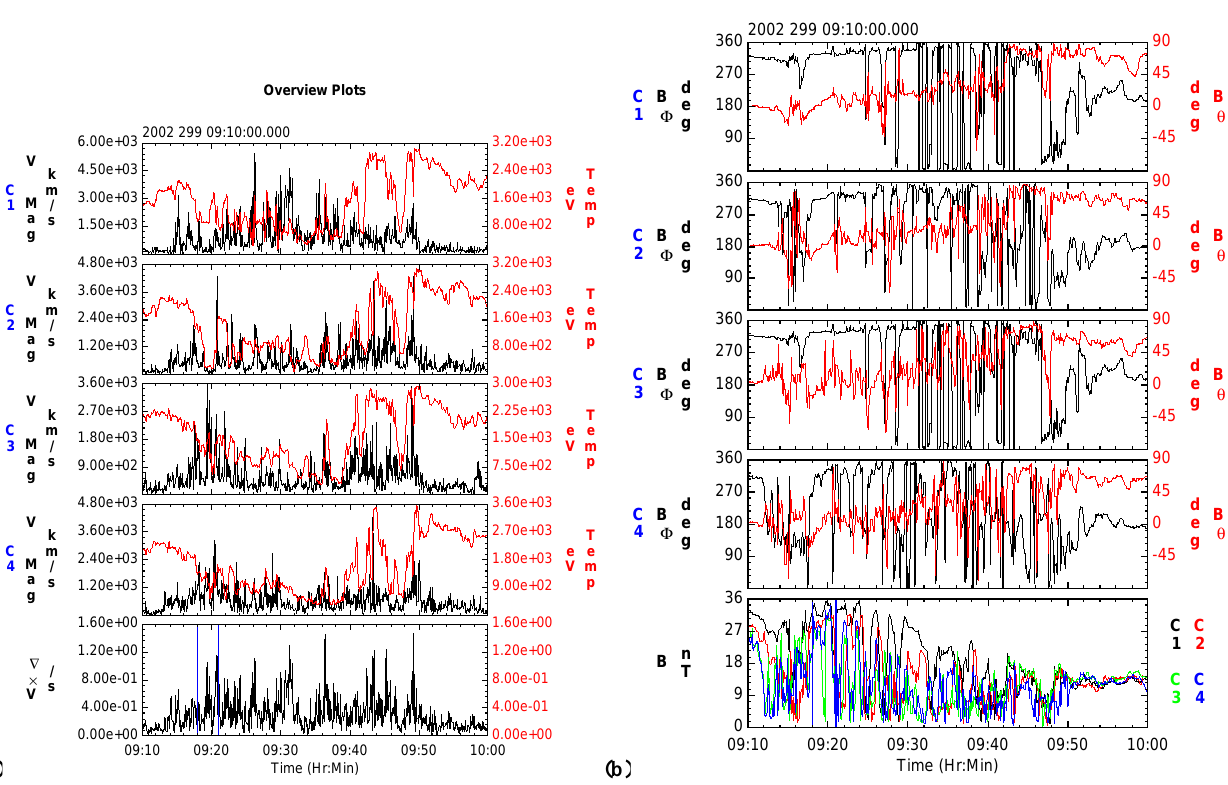
Fig. 7. Comparison of the total electron velocity and temperature and the magnetic field signatures from all four spacecraft across the vorticity burst seen in Fig.